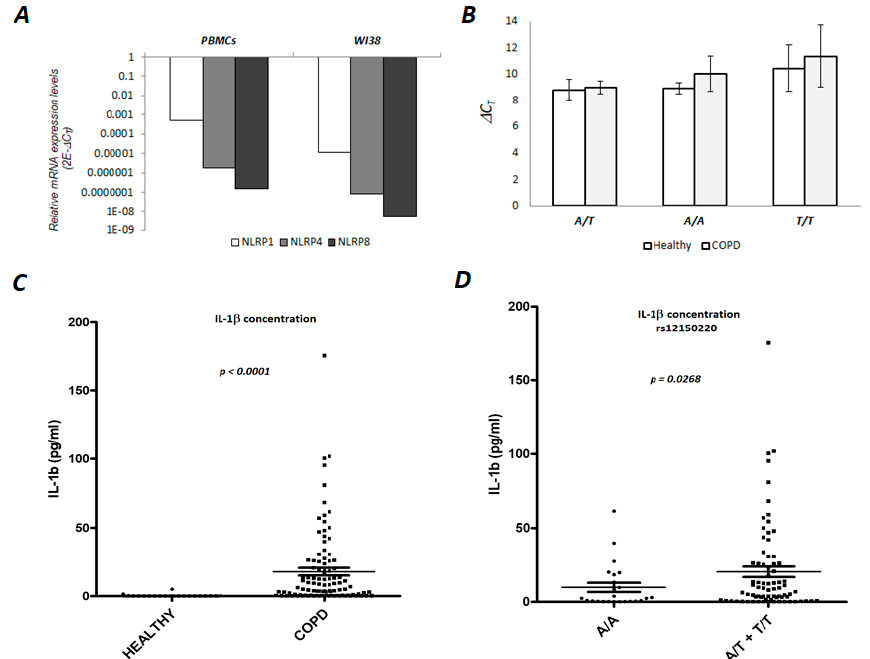
Figure 3. Expression analyses of selected genes in human PBMCs and lung fibroblast cells and serum IL-1 β concentration. ( A ) Real-time PCR analysis of NLRP1, NLRP4 and NLRP8 mRNA was performed on cDNA samples from COPD patients (N = 4) and WI38 cell line (human lung fibroblasts). Total